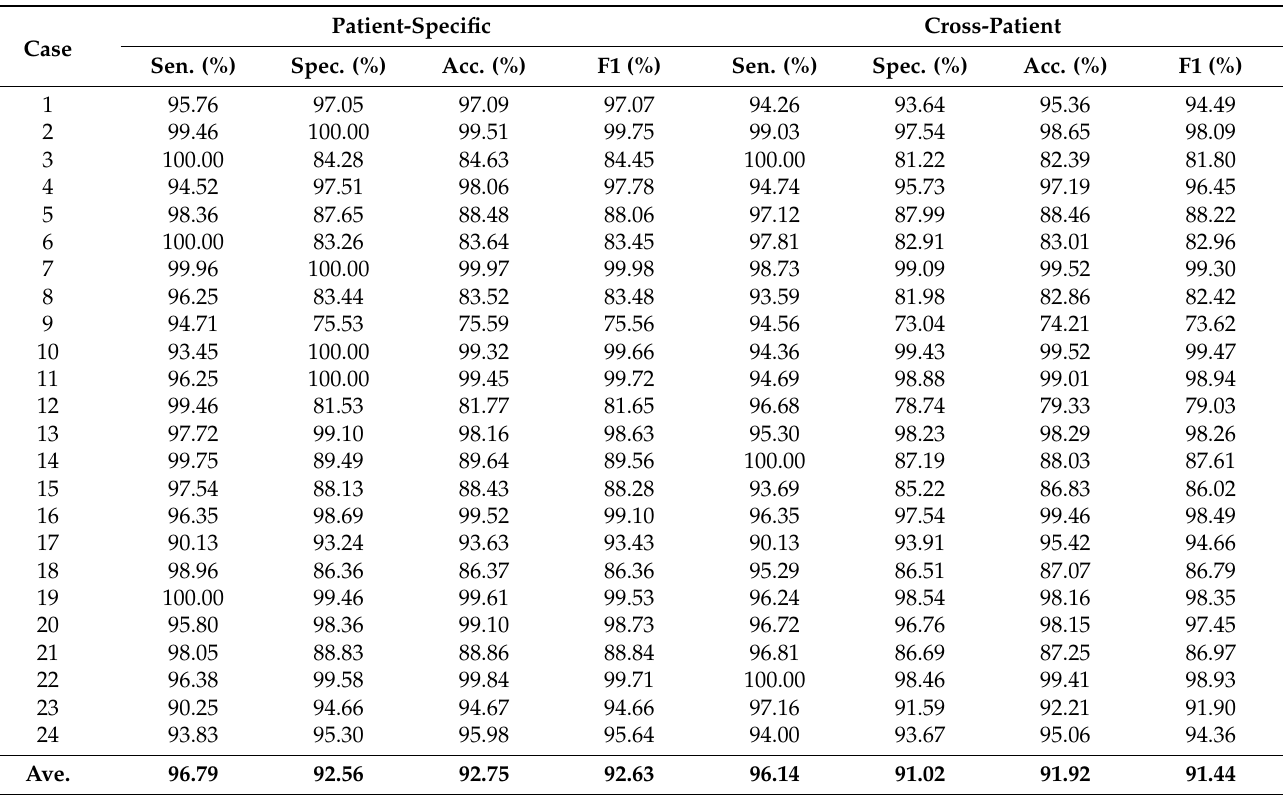
Table 4. Results of patient-specific and cross-patient